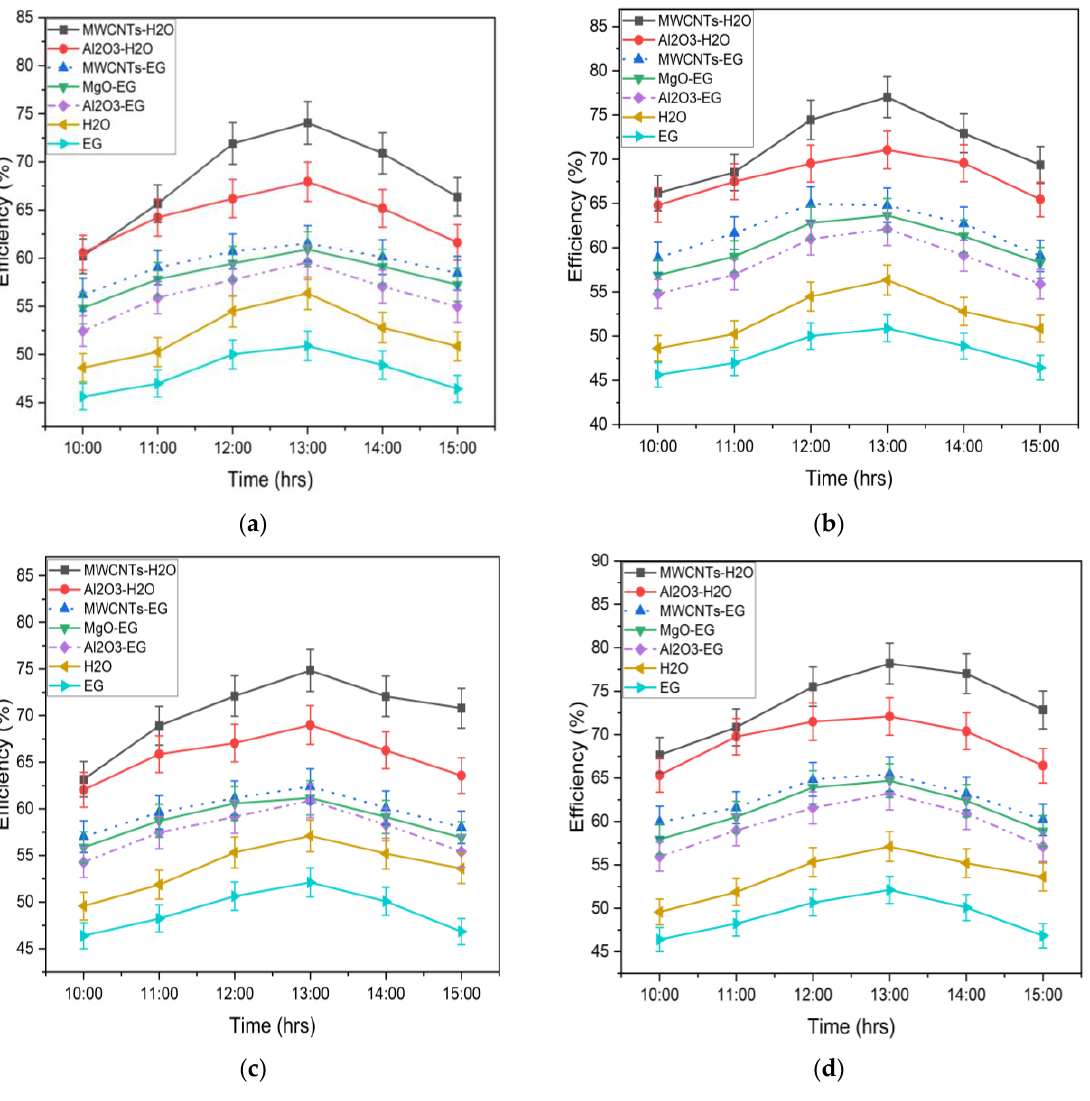
Figure 10. Comparison of thermal efficiency with regard to time: ( a ) 0.025 vol% at 0.02 kg/s, ( b ) 0.075 vol% at 0.02 kg/s, ( c ) 0.025 vol% at 0.015 kg/s, ( d ) 0.075vol% at 0.015 kg/s.